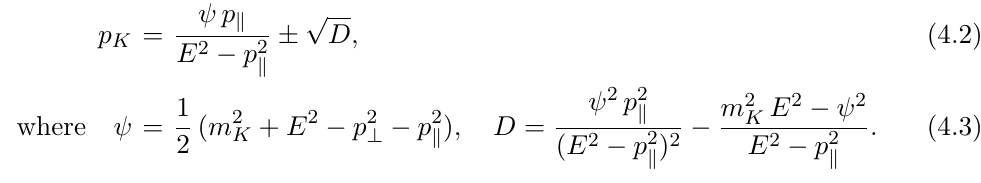
Figure 3 . Distributions of the reconstructed D variable for MC simulated K (cid:6) (right) signal and K (cid:6) ! (cid:25) (cid:6) (cid:25) 0 (cid:25) 0 background samples. The selection condition D < 900 (GeV = c ) 2